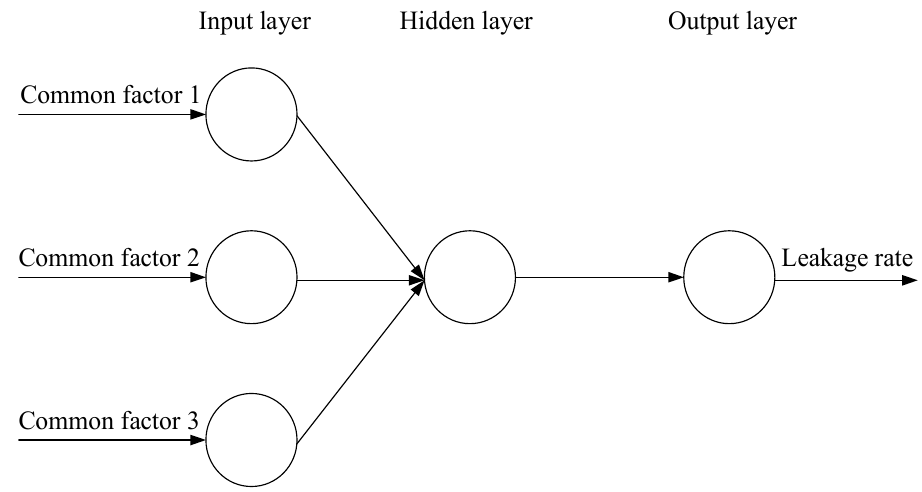
Figure 6. Optimal structure of the wavelet-BP neural network prediction model for valve internal leakage.